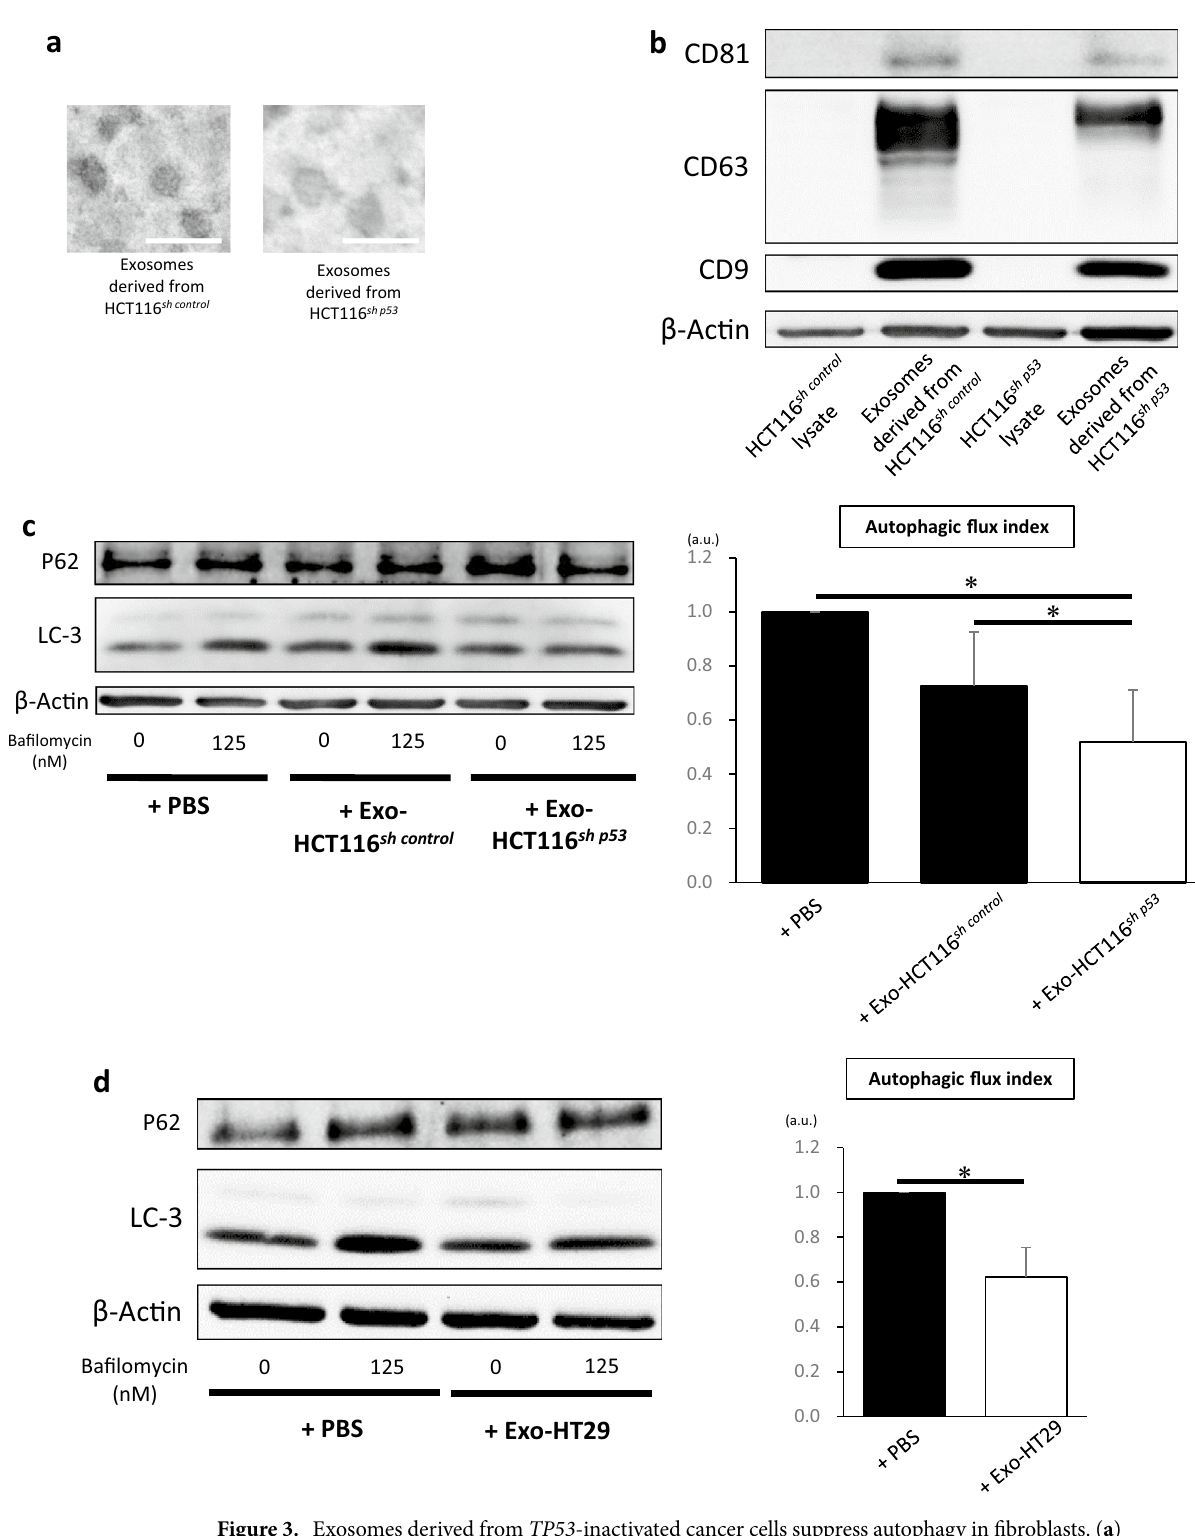
Figure 3. Exosomes derived from TP53 -inactivated cancer cells suppress autophagy in fibroblasts. ( a ) Representative transmission electron microscopy images of exosomes isolated from culture media of HCT116 sh control or HCT116 sh p53 cells. Scale bar: 100 nm. ( b ) Western blotting analysis of CD9, CD63, and CD81 in exosomes from HCT116 sh control or HCT116 sh p53 cells. ( c ) Western blotting and autophagic flux assays of CCD-18Co cells cultured with or without exosomes derived from HCT116 sh p53 (+ Exo-HCT116 sh p53 ) or HCT116 sh control cells (+ Exo-HCT116 sh control ) ( n = 5, mean ± SD, *P < 0.05). ( d ) Western blotting and autophagic flux assays of CCD-18Co cells cultured with (+ Exo-HT29) or without (PBS) exosomes derived from HT29 cells ( n = 5, mean ± SD, *P < 0.05). Protein expression levels were measured using imageJ software 1.8.0_172 (https:// imagej. nih.